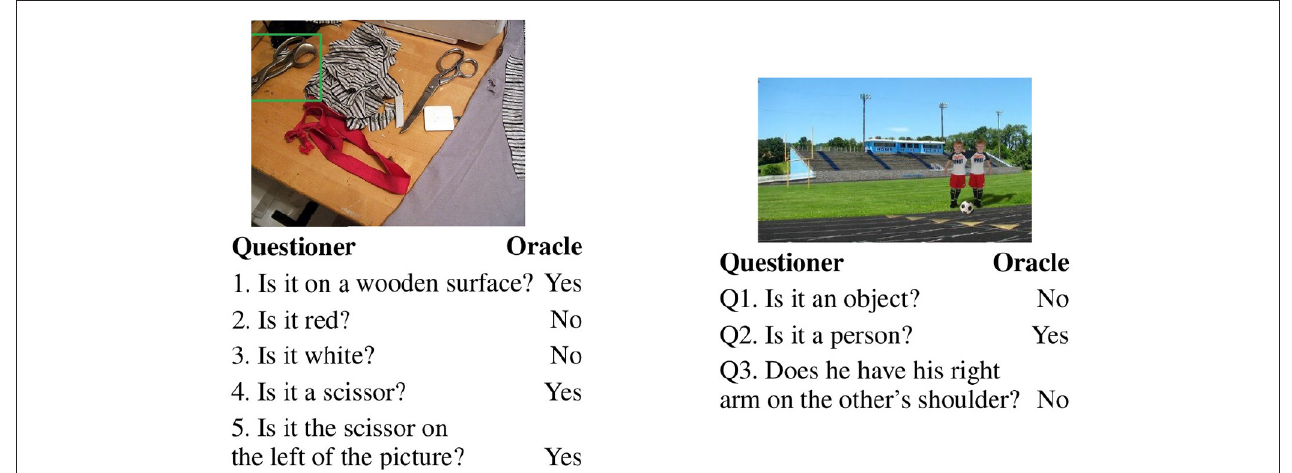
FIGURE 2 | Two samples of GuessWhat?! human dialogues ending with a positive (left) and a negative (right)